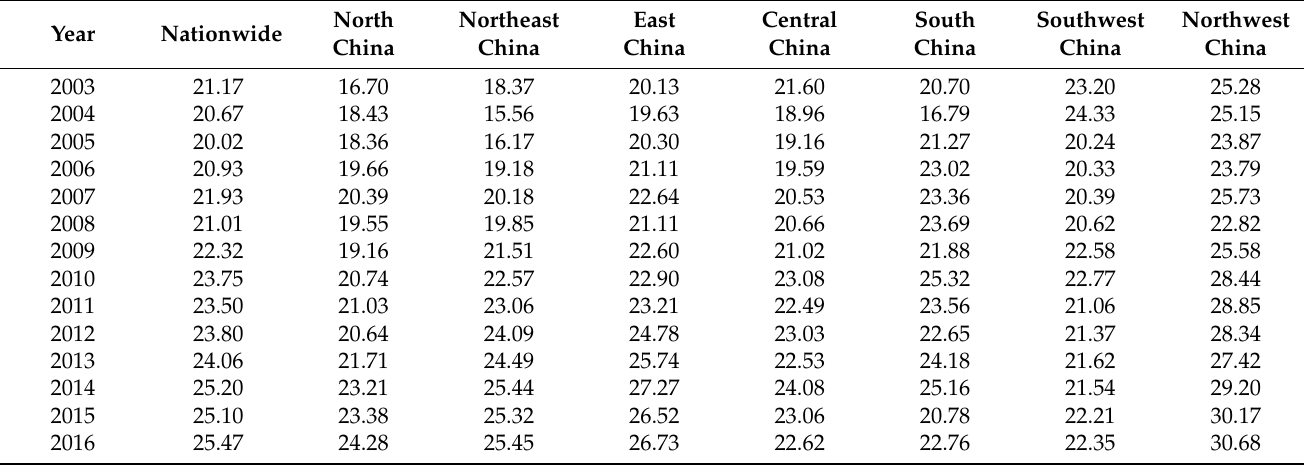
Table 2. Changes of fertilizer application rates for maize in China (unit: